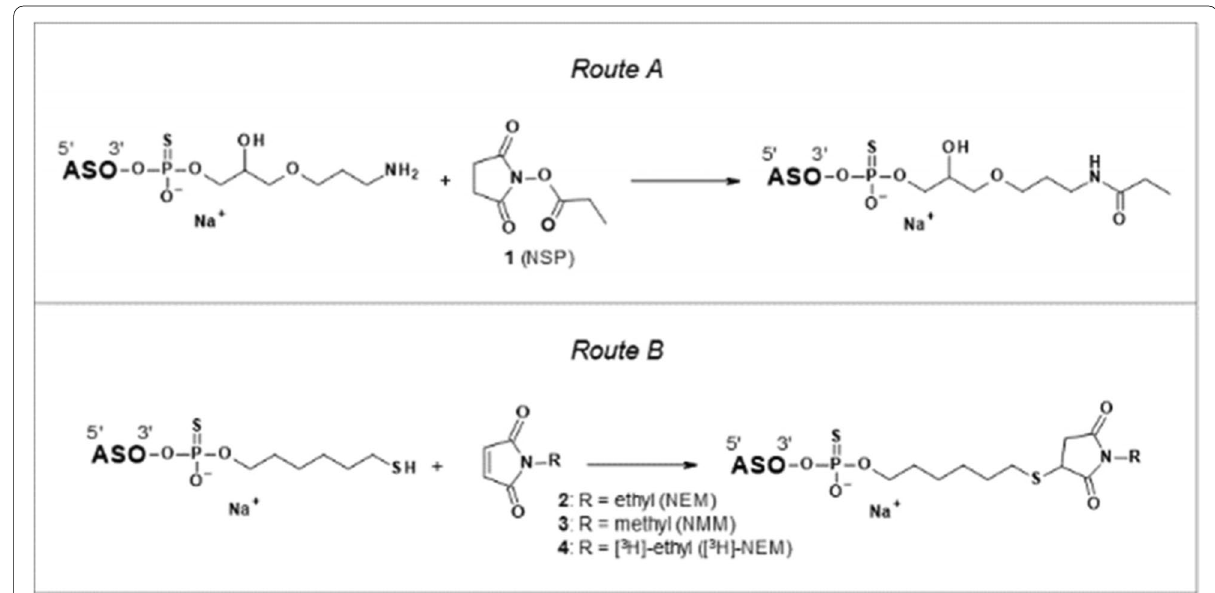
Fig. 2 Overview of different approaches applied in this study to introduce tritium labels to oligonucleotides by conjugation. Introducing propionyl using (1) N -succinimidyl propionate (NSP) to the 3 ′ -end via an aminopropyl glycerol-based linker ( Route A ), and via Michael addition of (2) N -ethylmaleimide (NEM), (3) N -methylmaleimide (NMM), or (4) N -[ 3 H]ethylmaleimide ([ 3 H]NEM) to a C 6 -thiol-linker at the 3 ′ -end ( Route B